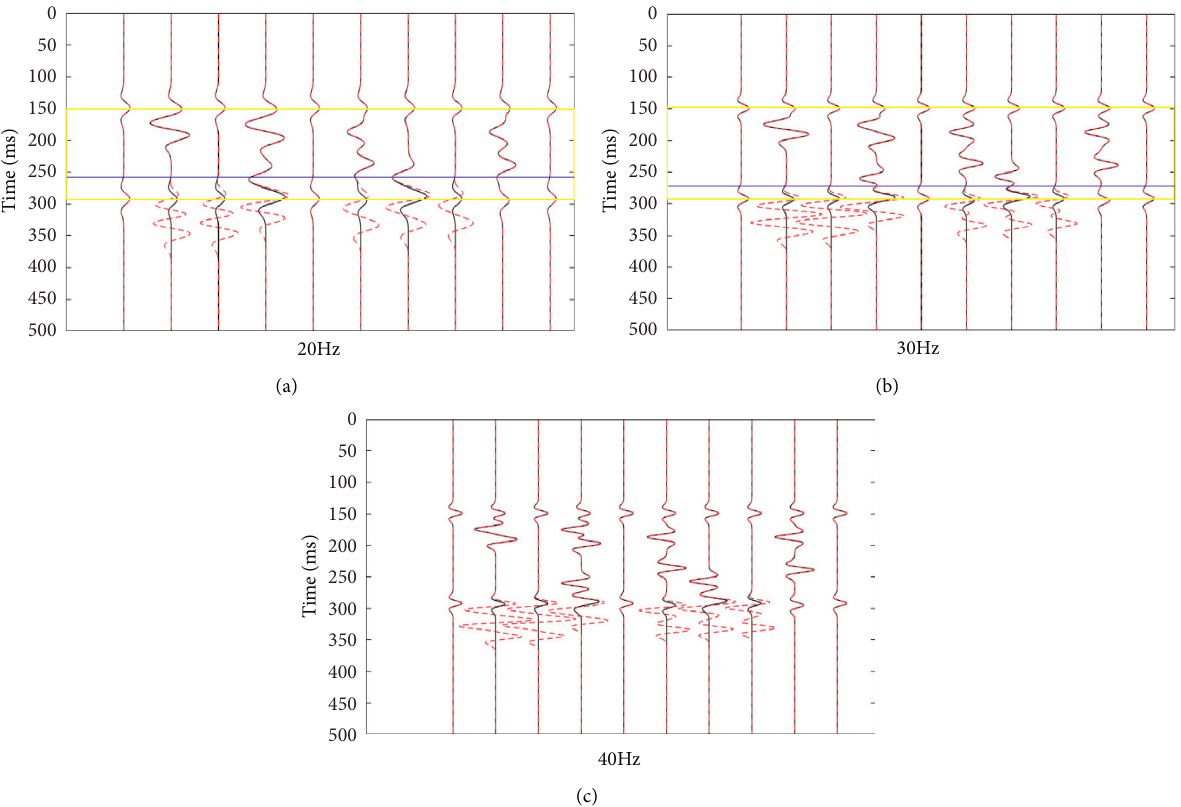
Figure 8: Comparison of waveforms of channel reservoirs with lower interference and noninterference at different frequencies. (a) 20Hz. (b) 30 Hz. (c) 40Hz. Table 2: Time corresponding to the zero-value points of the Ricker wavelet at different main frequencies. Main frequency (Hz) The time corresponding to the zero-value points (ms) Table 3: Time corresponding to the extreme value points of the Ricker wavelet at different main frequencies. Main frequency (Hz) The time corresponding to the extreme value points (ms)